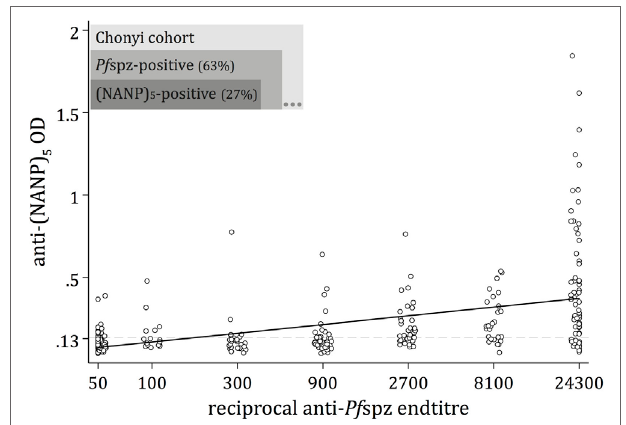
FigUre 1 | naturally acquired antibody responses against Plasmodium falciparum (Pf) sporozoites . Antibody responses to whole Pf sporozoites ( Pf spz) and to the central repeat region of the circumsporozoite protein were measured by immunofluorescence assay (IFA) on air-dried Pf spz and enzyme-linked immunosorbent assay (ELISA) using (NANP) 5 peptide, respectively. Anti- Pf spz end titers were defined as the last dilution at which sera recognized Pf spz by IFA. Anti- Pf spz antibody titers are log transformed. The (NANP) 5 -ELISA seropositivity cutoff (dashed line) was defined as the mean optical density (OD) plus 3 SDs of 20 sera from unexposed individuals (OD = 0.135). Serum from a hyperimmune Kenyan adult (20H) served as a positive control; black line: fitted regression line;